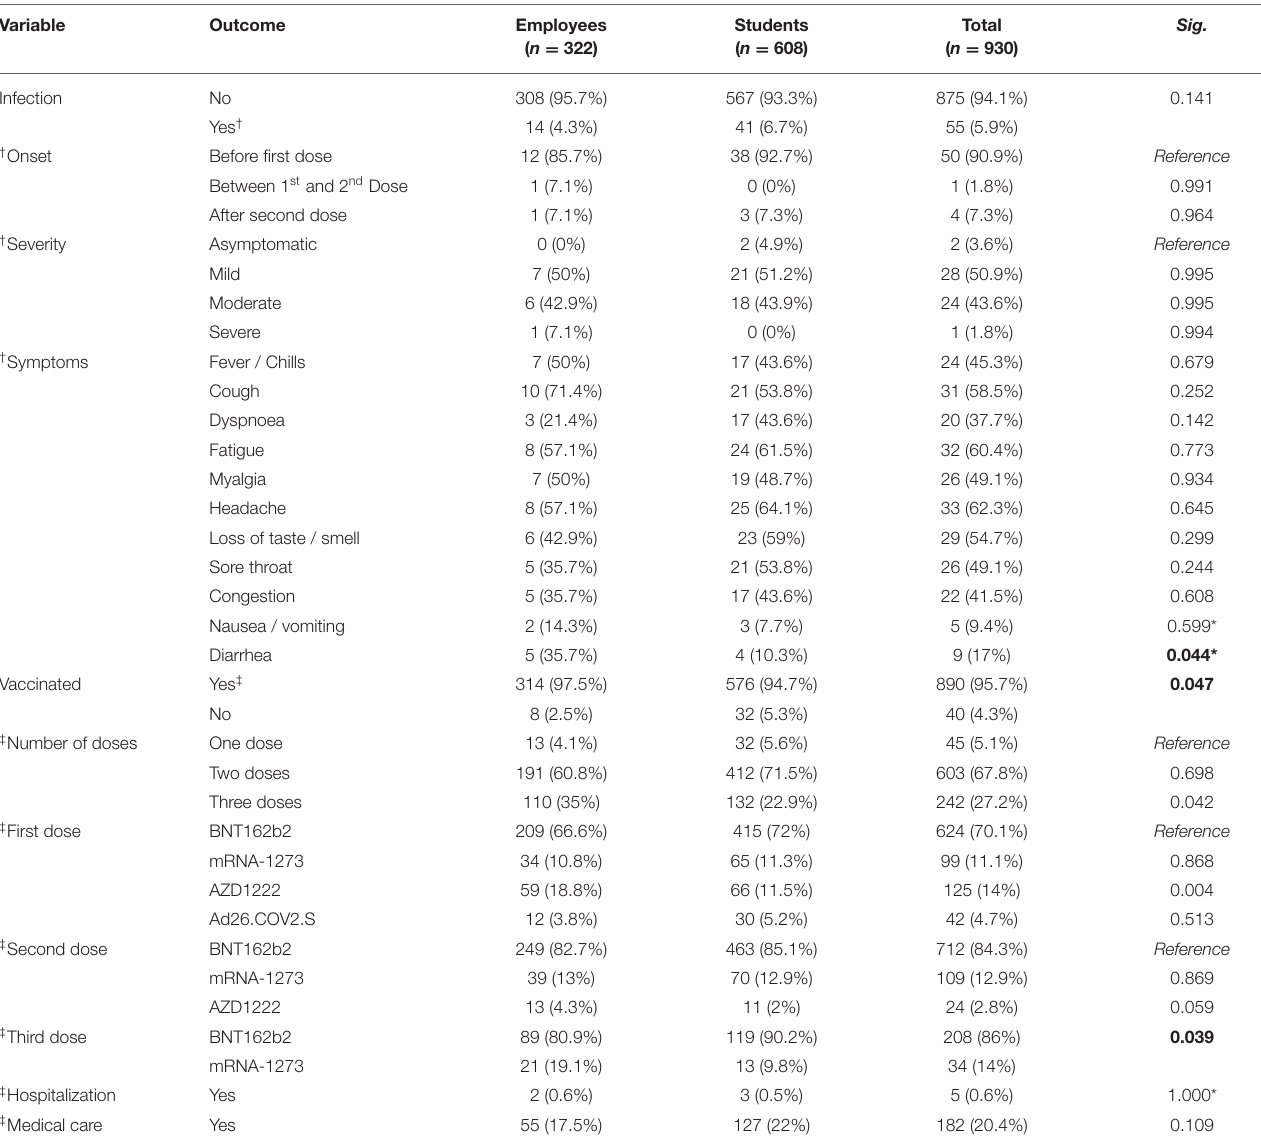
TABLE 2 | COVID-19-related anamnesis of German university students and employees participating in the COVID-19 Vaccine Booster Hesitancy (VBH) Survey, december 2021 ( n = 930). Variable